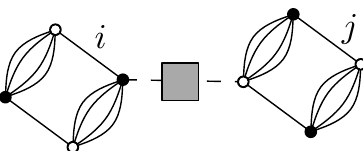
Figure 3. Typical graph contributing to the interaction of V ( 3 ) of degree